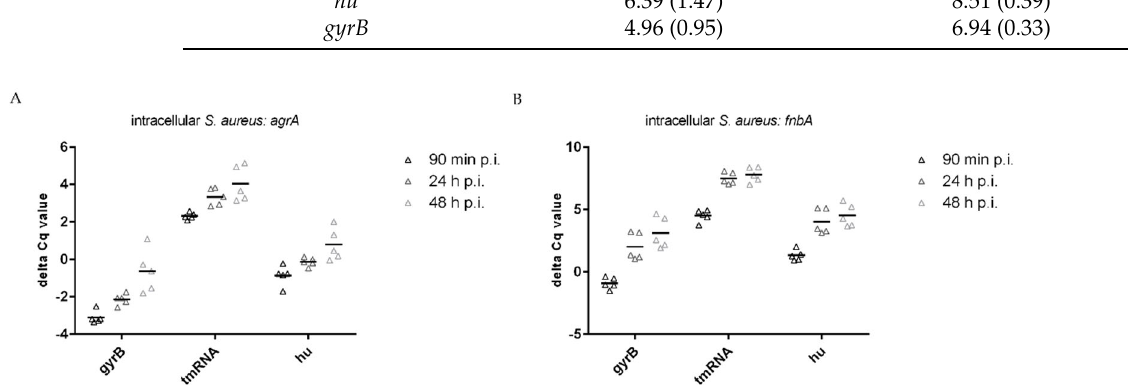
Figure 6. Variability of delta C q values of intracellular S. aureus at 90 min, 24 h, and 48 h postinfection